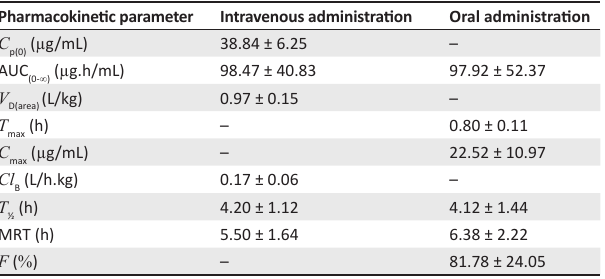
FIGURE 1: Mean (± SEM) lincomycin plasma concentration–time profile after intravenous and oral administration to cats at a dosing rate of 15 mg/kg ( n = 5). TABLE 1: Pharmacokinetic parameters (mean ± s.d.) of lincomycin after intravenous and oral administration to cats at a dosing rate of 15 mg/kg ( n = 5). Pharmacokinetic parameter